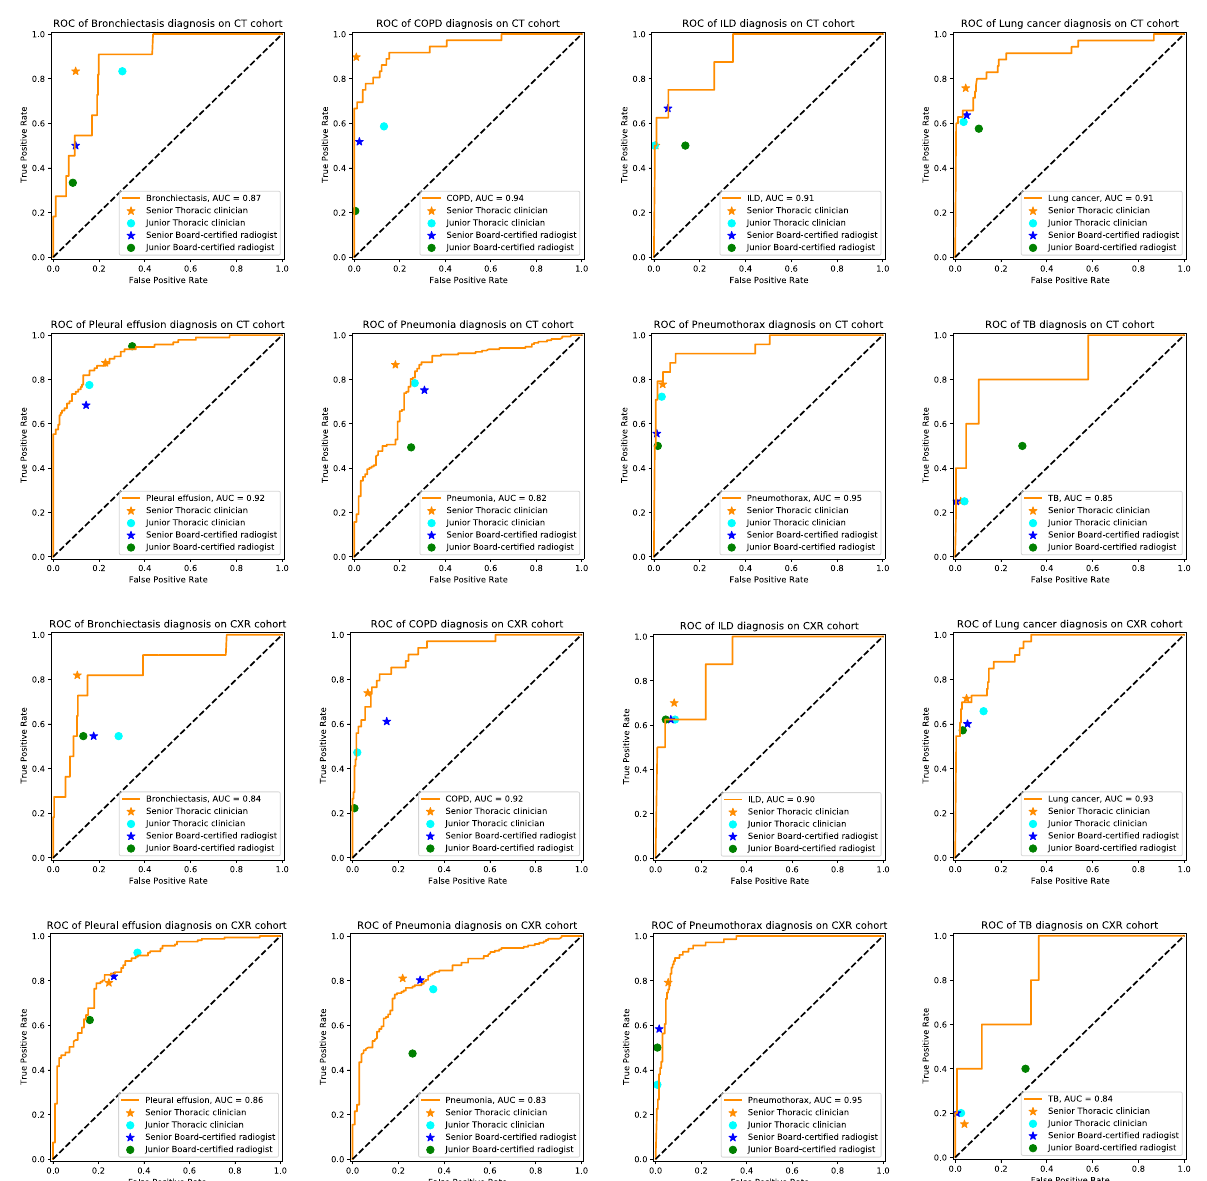
Fig. 4 Model performance of the AI system in making multi-disease classi fi cation compared with experts on the CT and CXR cohorts. ROC curves for diagnostic performance in the comparison between our AI system and four groups of experts (senior/junior thoracic clinicians and senior/junior radiologists). COPD chronic obstructive pulmonary disease, ILD interstitial lung disease, TB tuberculosis.